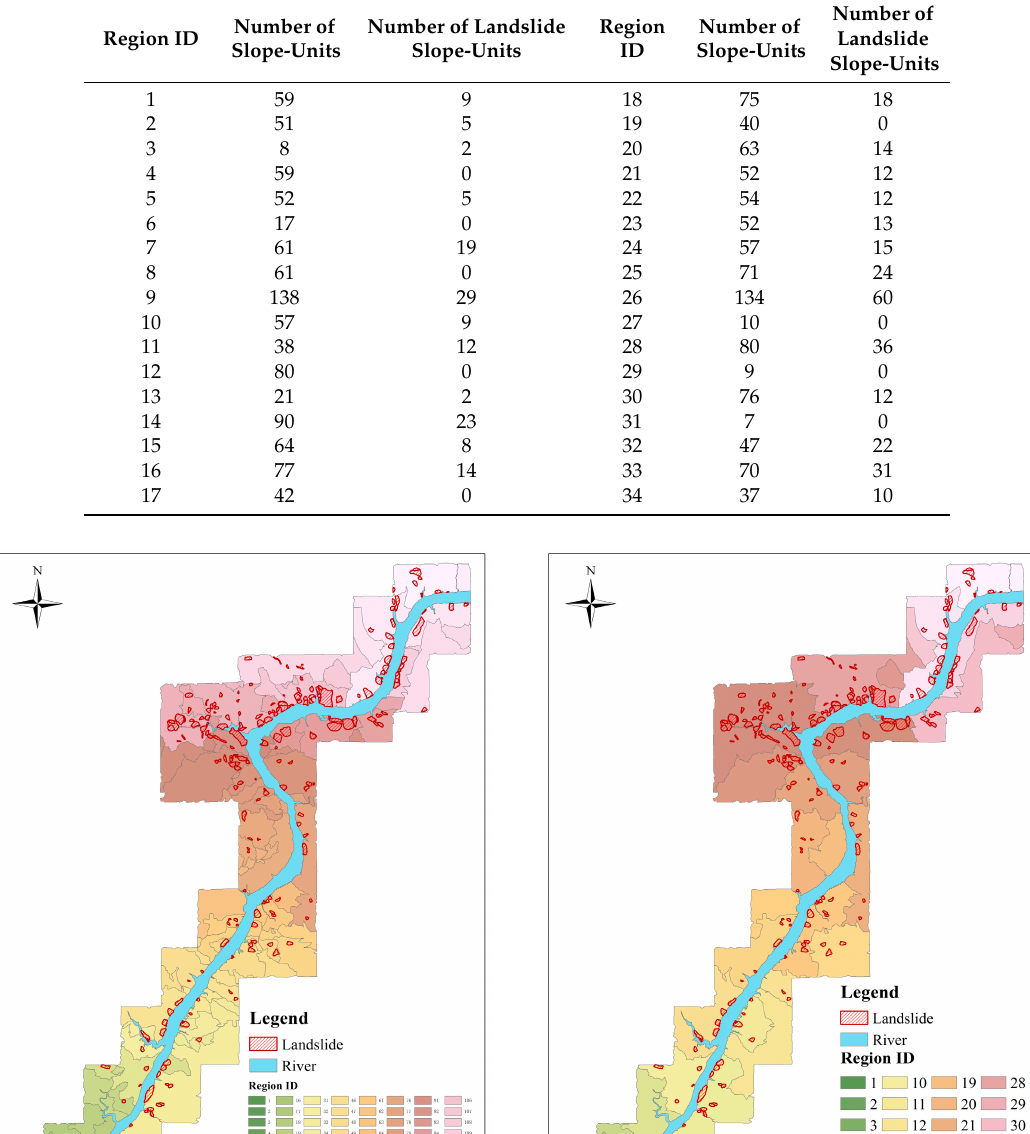
Table 7. The numbers of the total slope-units and the landslide slope-units for each prediction region. Region Number of Number of Landslide ID Slope-Units Slope-Units 59